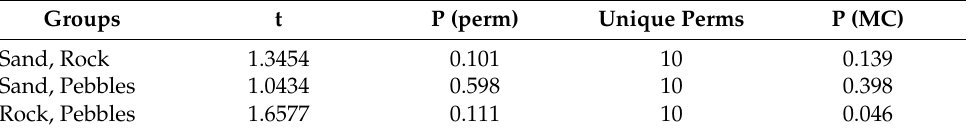
Table 7. Results of pair-wise tests for scavenging benthopelagic macrofaunal assemblages between habitats.